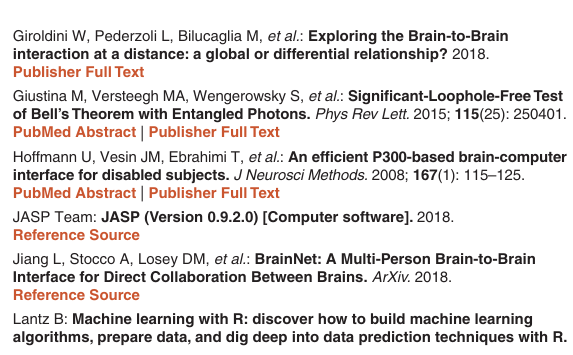
First dataset: Figshare: EEG correlates of social interaction at dis- tance, http://dx.doi.org/10.6084/m9.figshare.1466876 (Tressoldi, 2016). Second dataset: Figshare: Brain-to-Brain interaction at a distance: a global or differential relationship? https://doi.org/10.6084/ m9.figshare.5132647.v7 (Tressoldi et al ., 2018)